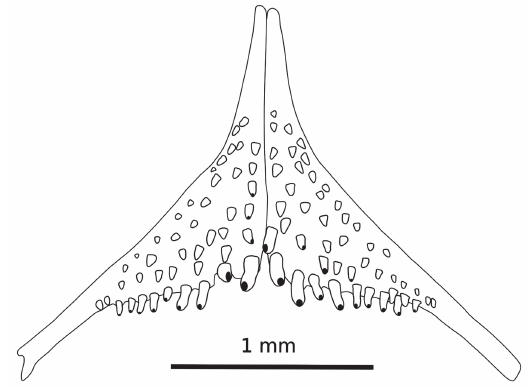
Fig. 3. Lower pharyngeal tooth plates of Crenicichla anamiri in occlusal view, INPA 44344, 26.3 mm SL. Color in alcohol. Similar to live specimens but without